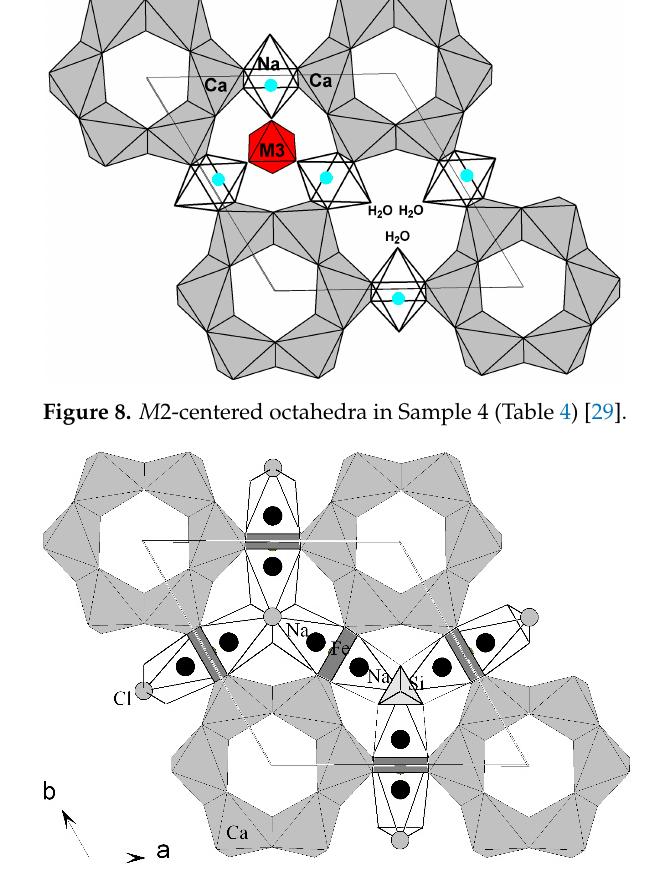
Figure 9. Seven-vertex M 2 polyhedra in Sample 3 (Table 4) [32].